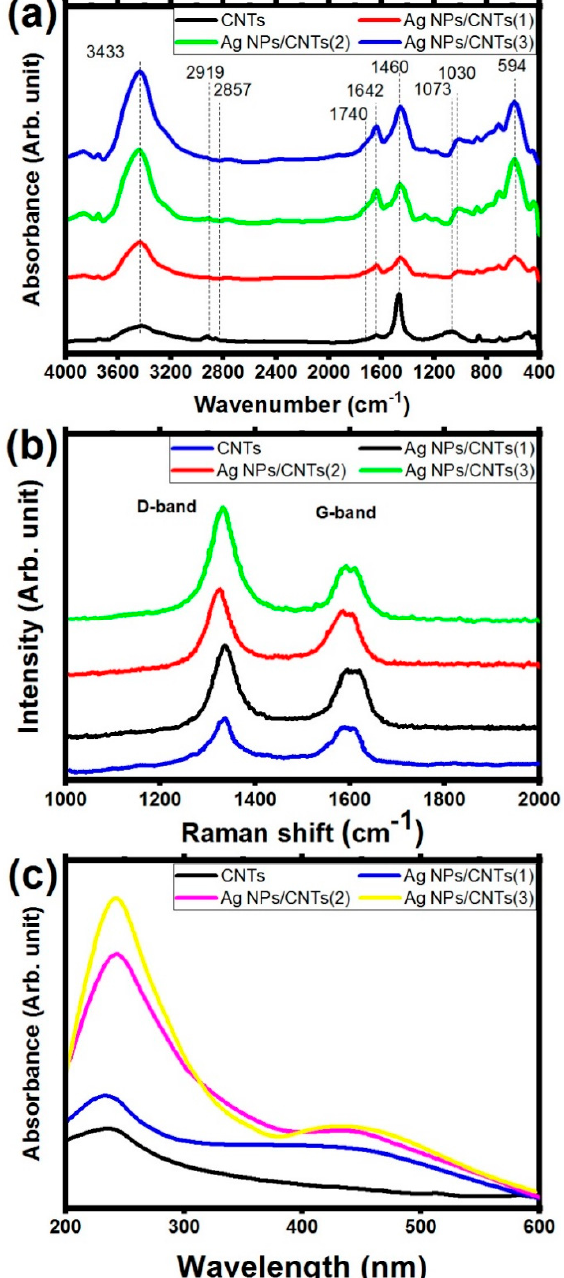
Figure 3. ( a ) FT–IR spectra, ( b ) Raman spectroscopy, and ( c ) UV-visible spectroscopy of the used CNTs and their decoration by Ag NPs with different concentrations based on tuning laser ablation time.